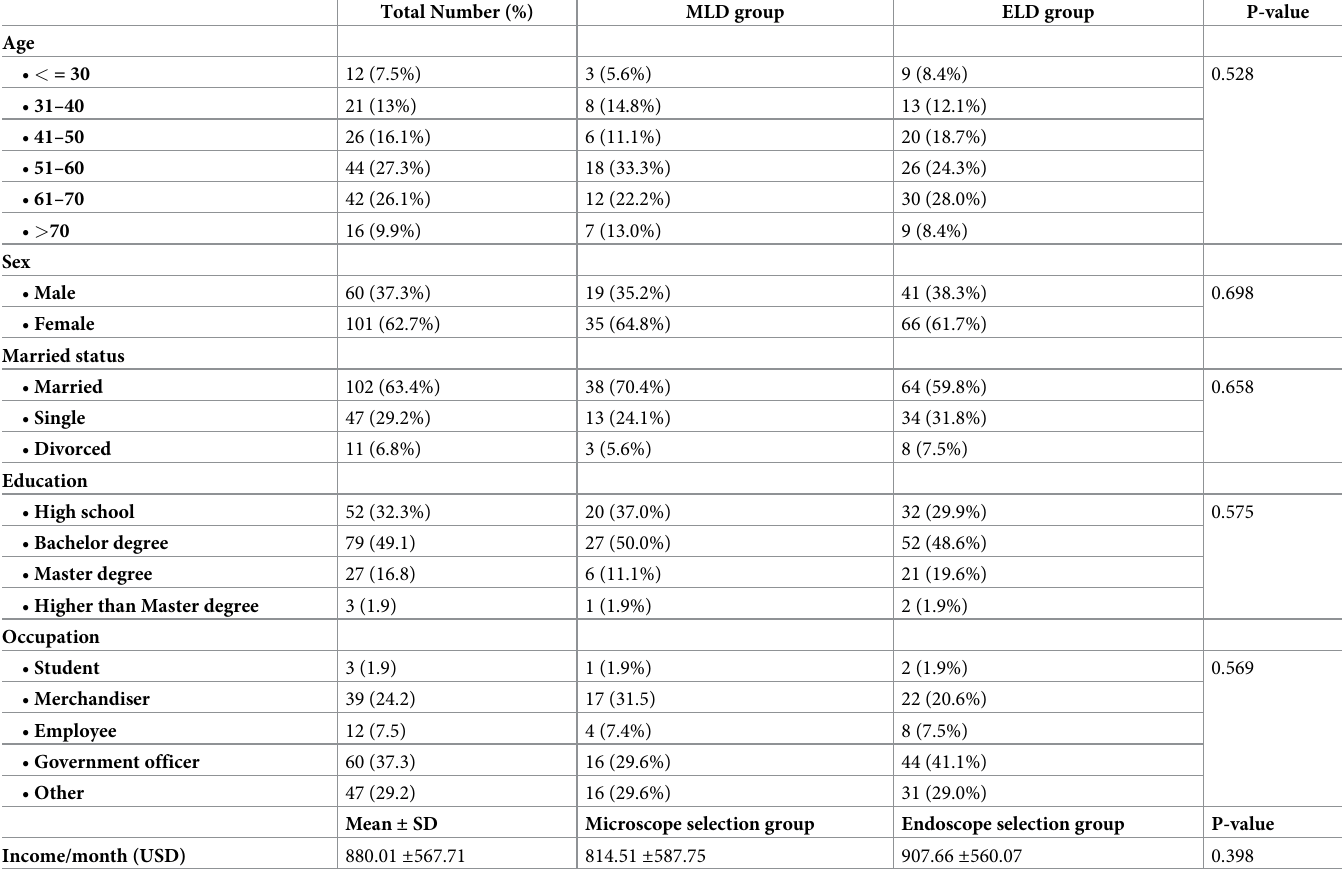
Table 1. Demographic data of participants in the study.